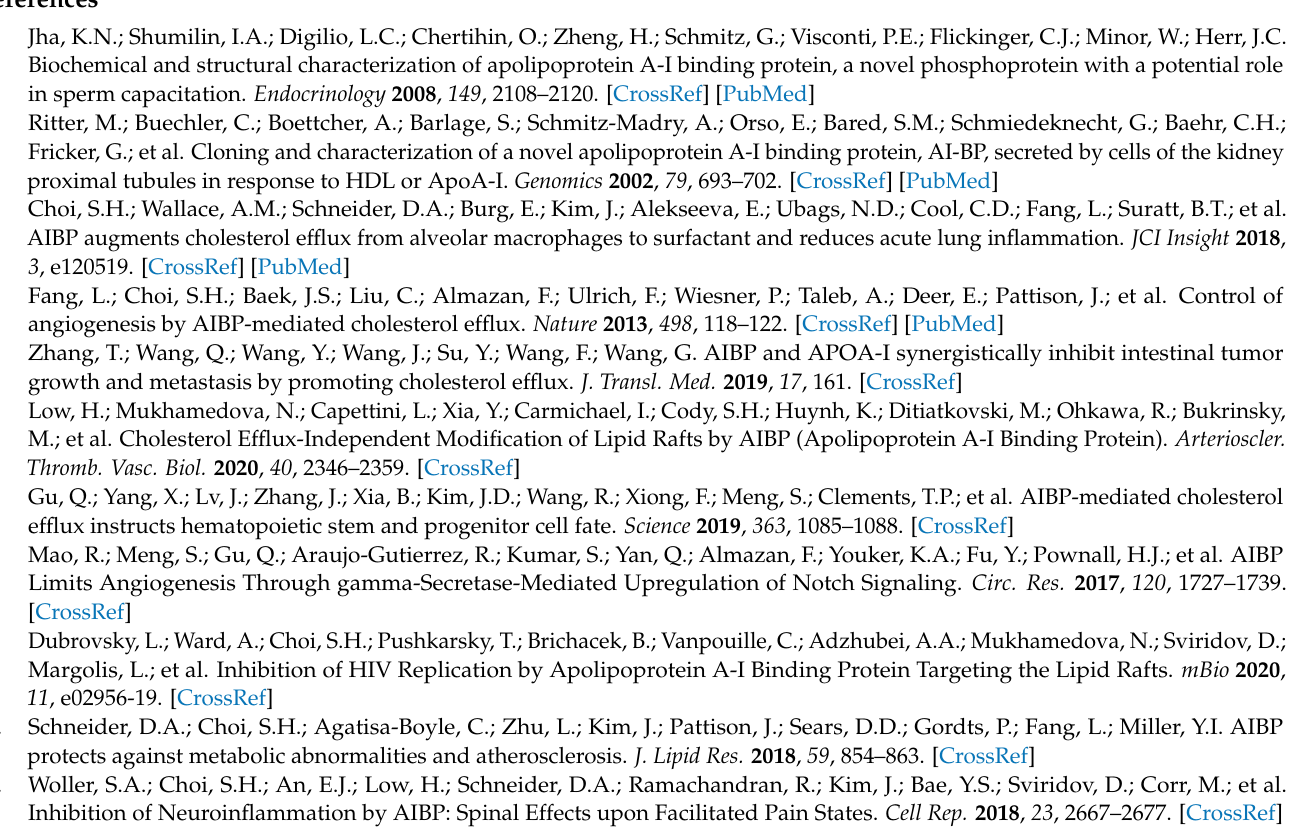
Figure S3: Effect of NAXE on mitochondrial respiration in HUVECs. Table S1: Untargeted